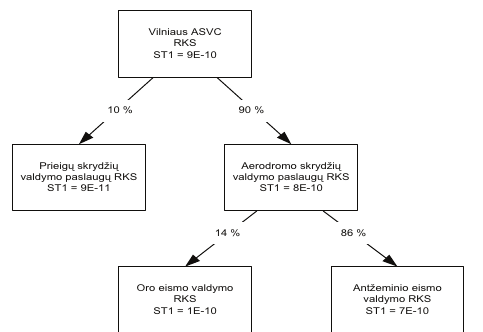
Fig. 3. A-SMGCS risk classification scheme